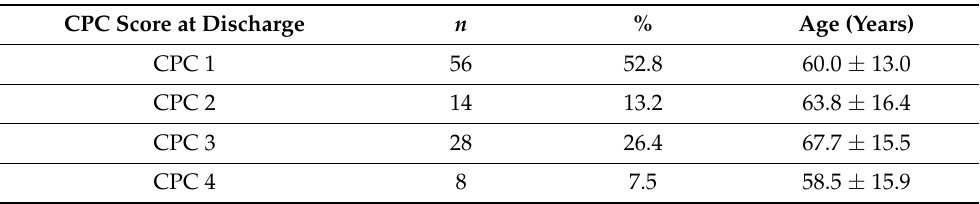
Table 2. Neurological outcome of surviving patients at discharge. Data regarding CPC score was available in 106 (96.4%) of